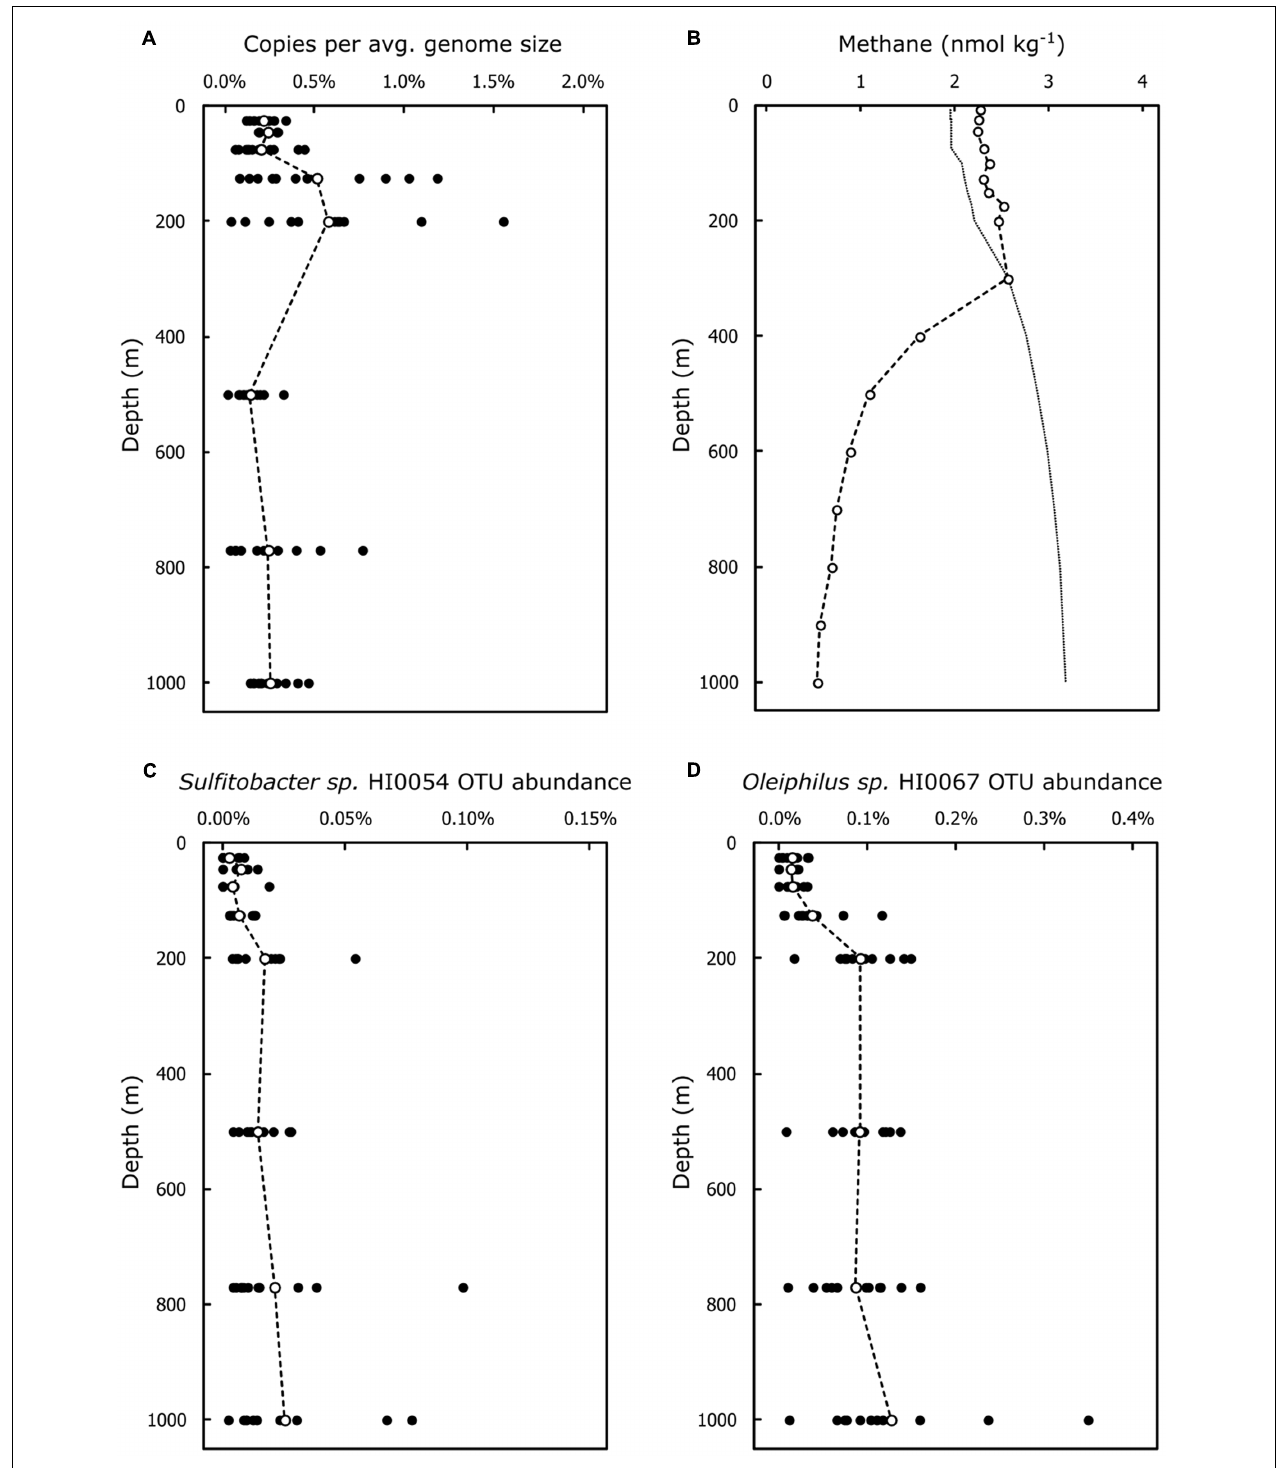
FIGURE 3 | Abundance of the C-P lyase pathway genes and of OTUs representative of HMWDOM enriched bacterial isolates encoding C-P lyase at Station ALOHA. (A) The average copy number of C-P lyase pathways genes with catalytic functions normalized to average genome size. (B) Typical depth profile of methane concentrations in the water column at Station ALOHA. Indicated are the average methane concentrations in samples collected during Spring 2013 (Hawaii Ocean Time-series cruises 249–251). The predicted methane concentrations in equilibrium with the atmosphere are indicated by the dotted line. (C) OTU proportional abundance of SSU rRNA sequences representative of Sulfitobacter sp. HI0054. (D) OTU proportional abundance of SSU rRNA sequences representative of Oleiphilus sp. HI0067. Closed circles represent abundances for individual samples. Open circles indicate the mean abundances for all samples at a given depth.